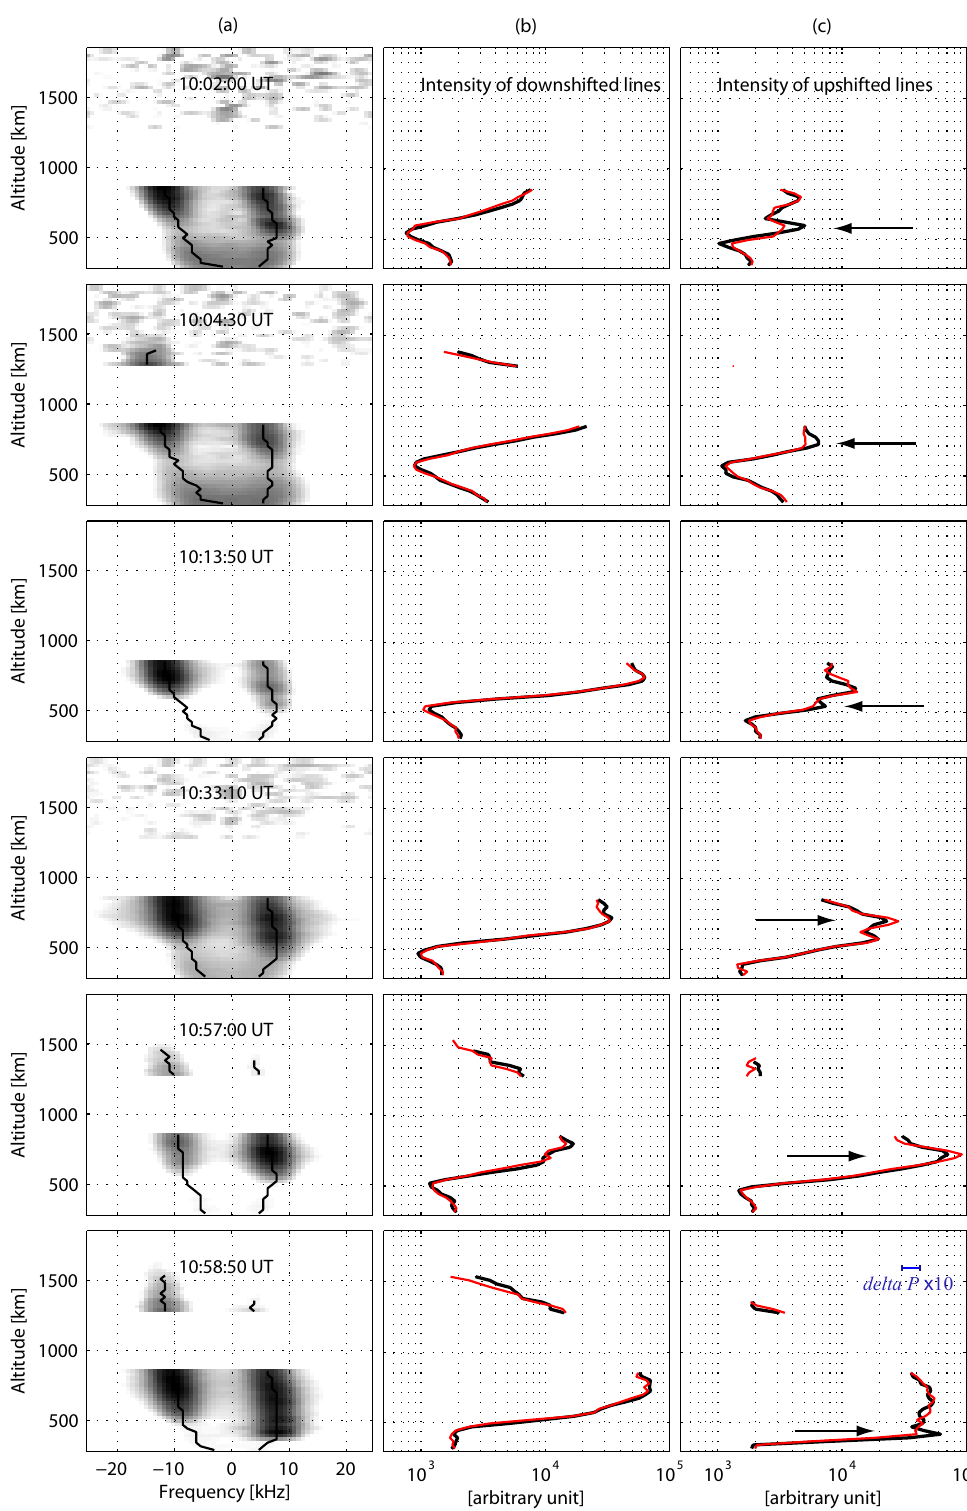
Fig. 8. Fig. 8. Power of the NEIALs from channel 1 (Transmitting frequency of 498.1MHz) and channel 5 (Transmitting frequency of 501.9MHz) on 28 July 2000. (a) Gray coded IS spectra of channel 1. (b) Peak intensity (arbitrary units) of the downshifted ion-acoustic line in channel 1 (black line) and channel 5 (red line). (c) Same as (b), for the upshifted lines in channel 1 and channel 5. The arrows show where the intensities of the upshifted lines differ most between channels 1 and